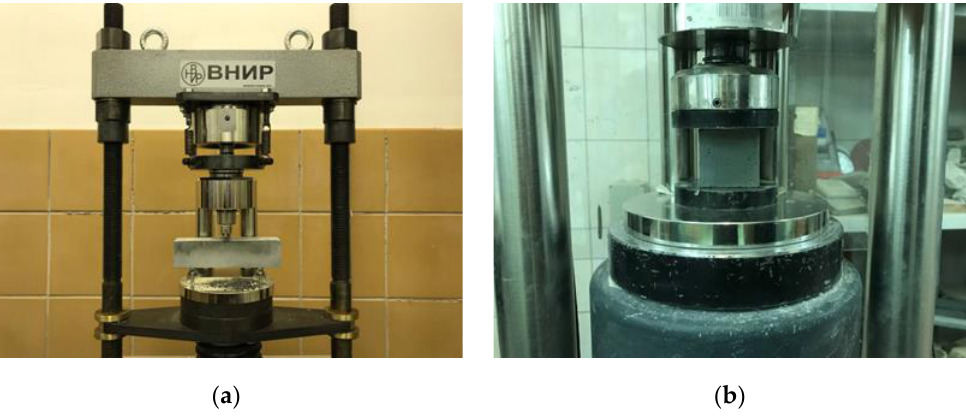
Figure 2. Equipment used to perform the bend ( a ) and compression ( b )